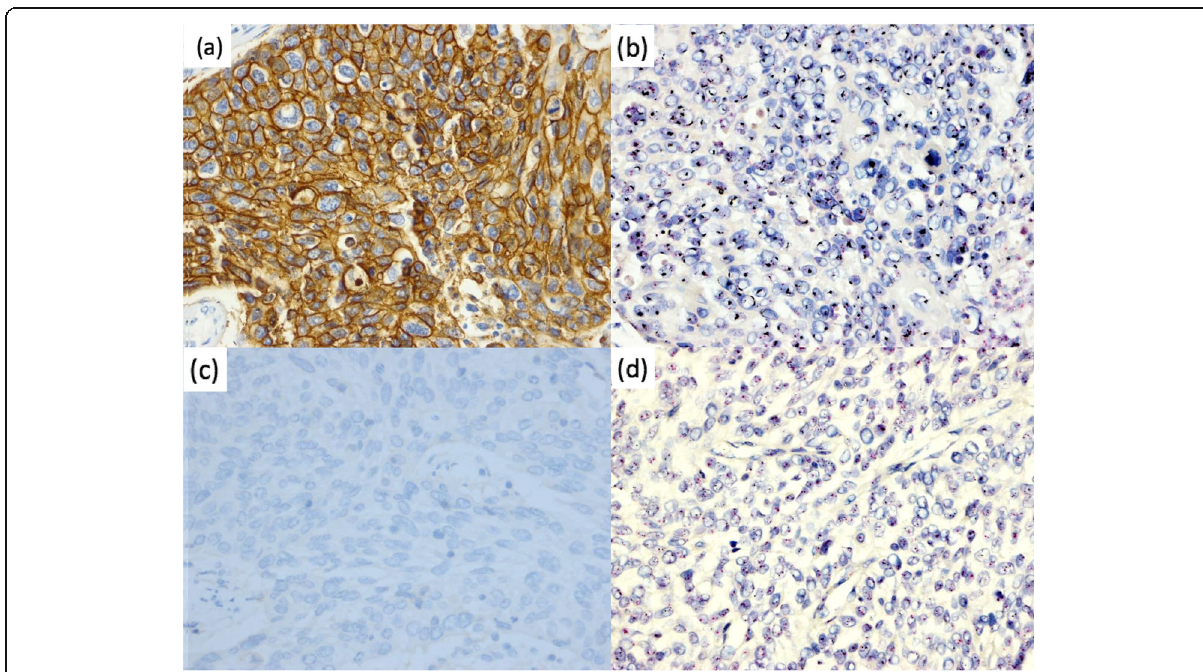
Fig. 2 HER2 expression and amplification in esophageal squamous cell carcinoma by immunohistochemistry and dual-color in situ hybridization. a HER2 overexpression in tumor cells based on IHC. Original magnification, 400×. b HER2 gene amplification in tumor cells based on